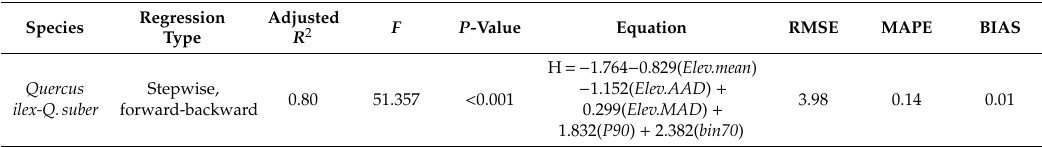
Table 4. Allometric equation used for individual tree height estimation (h = total height, m) through LiDAR metrics, for the Quercus ilex-Q. suber forest plantation in Andalusia (Southern Spain). Independent variables ( Elev.mean = the mean; Elev.AAD = average absolute deviation; Elev.MAD = the median of median absolute deviation; P90 = Elevation percentile 90; bin70 = Fraction of return points between the 70th percentile height and the maximum height). Adjusted determination coe ffi cient ( R 2 ), P -value and F . Root mean square error (RMSE, %), Mean Absolute Percent Error (MAPE) and persistent forecast error (BIAS,